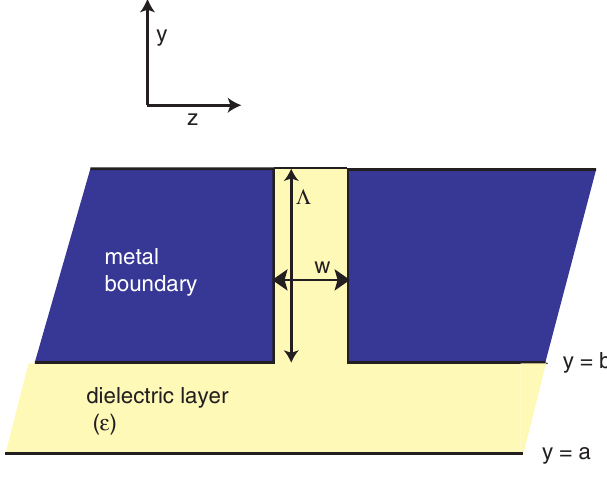
FIG. 2. (Color) Detail of coupling slot geometry, showing pa- rameters used in the